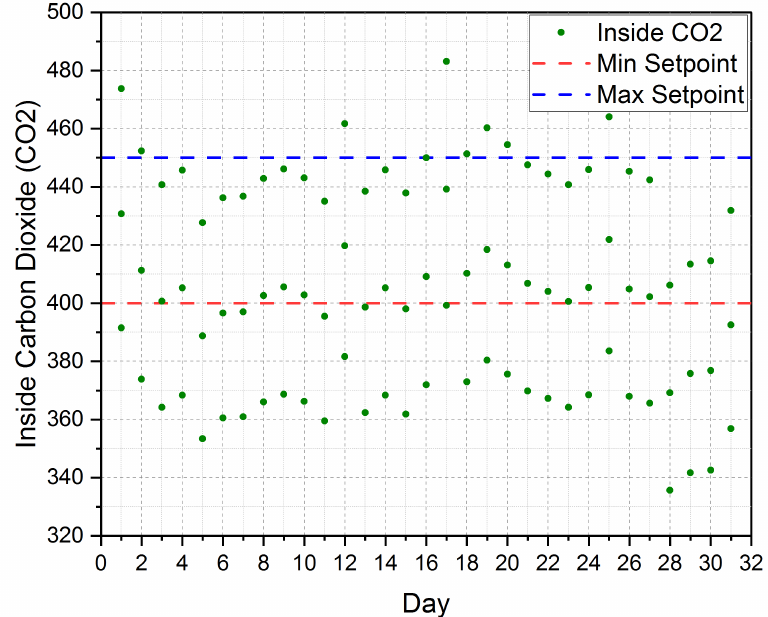
Figure 12. The three months average for inner carbon dioxide (Inside CO 2 ) according to the minimum (Min Setpoint) setpoint and maximum setpoint (Max Setpoint) considered in our